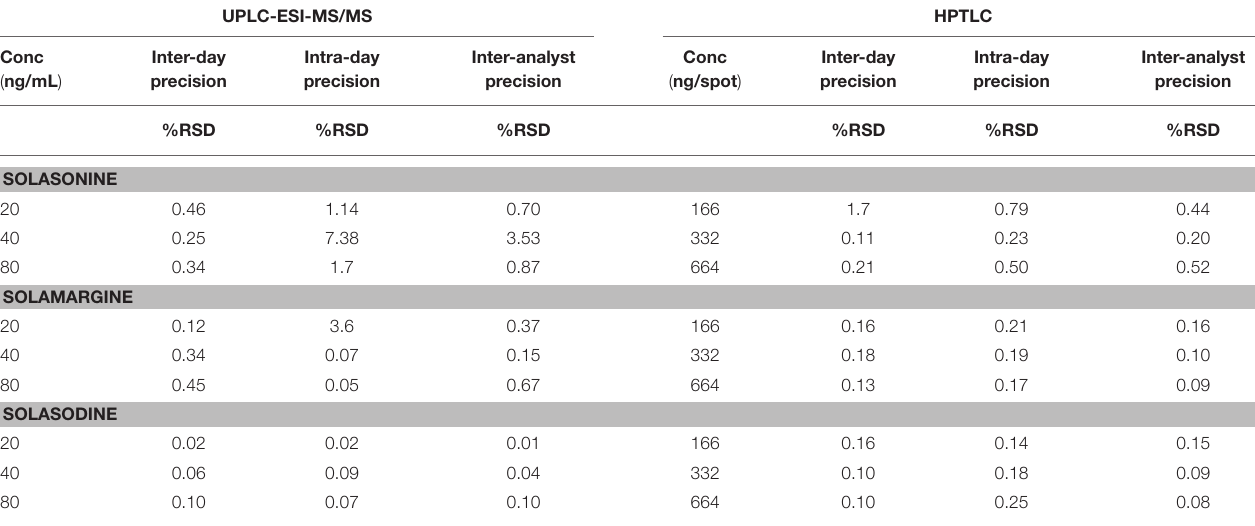
TABLE 4 | Precision of UPLC-ESI-MS/MS and HPTLC method for estimation of mixed standards ( n =